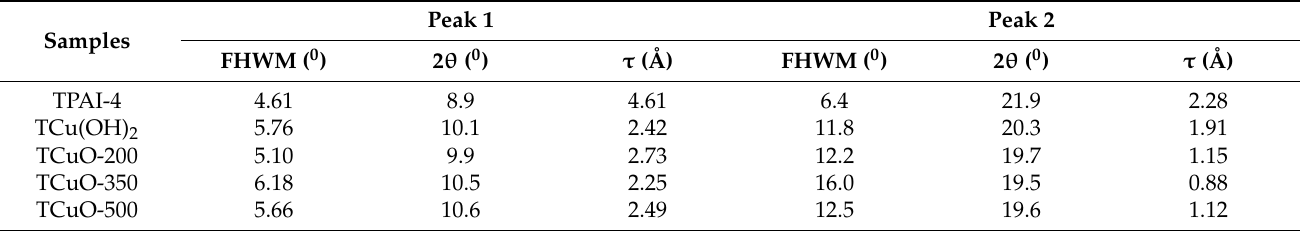
Table 1. τ of all the PCGE